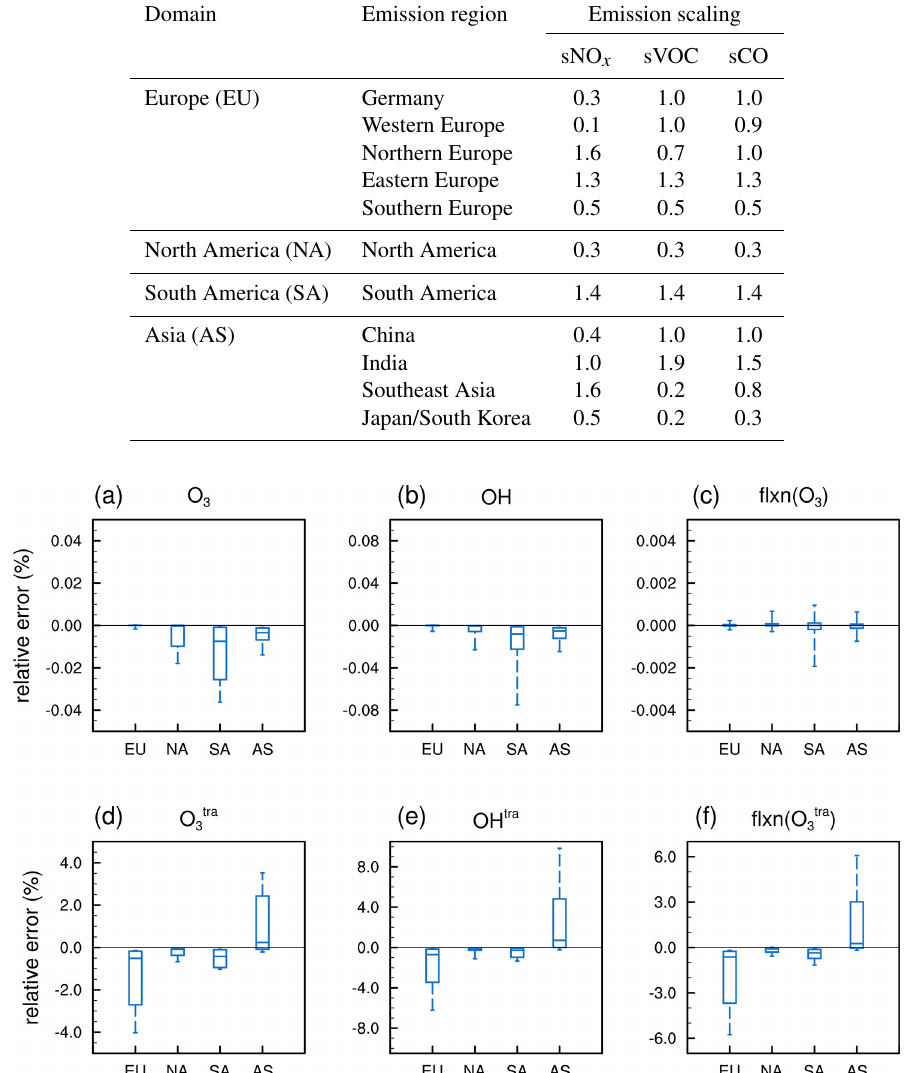
Figure 6. Box plot of the relative errors between the simulations performed with TransClim and EMAC for the domains Europe (EU), North America (NA), South America (SA) and Asia (AS). The whiskers show the 5th and 95th percentiles. The relative errors for the variables O 3 (a) , OH (b) and flxn(O 3 ) (c) as well as the contributions O tra errors of the tropospheric columns are shown. For OH and OH tra , the deviations of the tropospheric means are displayed. For flxn(O 3 ) and flxn(O tra ), the values at the top of the atmosphere are taken into 3